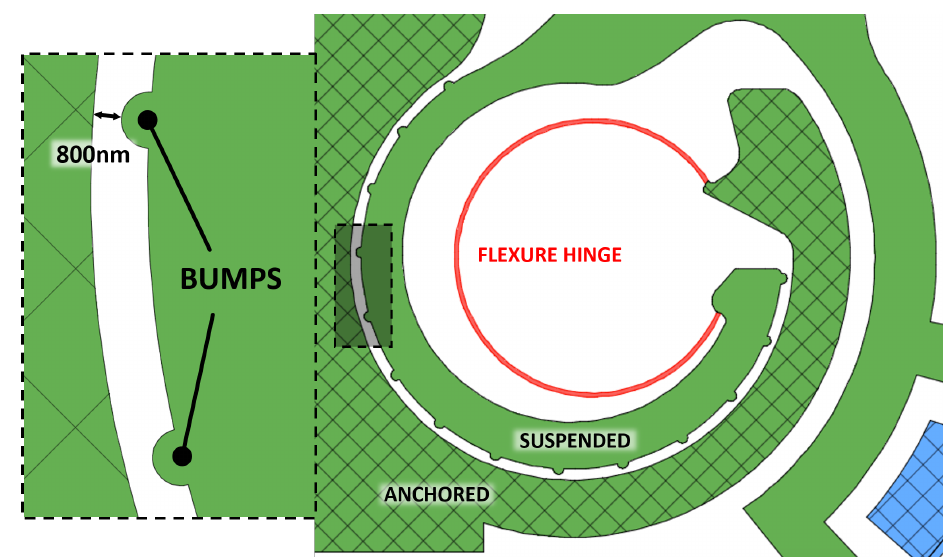
Figure 4. Conjugate Surface Flexure Hinge (CSFH) with